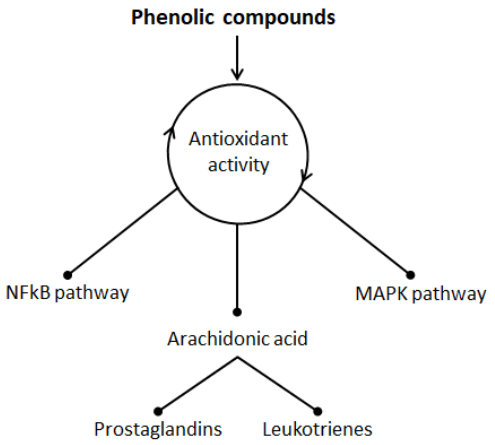
Figure 8. Potential mechanisms of actions for antioxidant phenolic compounds as immunomodulatory and anti-inflammatory agents [66]. These mechanisms work mainly through inhibition of two key signaling pathways; the mitogen-activated protein kinases (MAPK) and the nuclear factor kappa-light-chain-enhancer of activated B cells (NF- κ B) and arachidonic acid signaling pathways. This inhibition results in complicated cellular mechanisms finished with suppression of pro-inflammatory gens, and thus block the expression of pro-inflammatory cytokines (e.g., tumor necrosis factor-alpha (TNF) and interleukin (IL)-6). In addition, the phenolic compounds also reduce the release of arachidonic acid which results upon the oxidation of membrane phospholipids, and thus reduce also its metabolites (leukotrienes and prostaglandins) that considered as important inflammatory mediators.